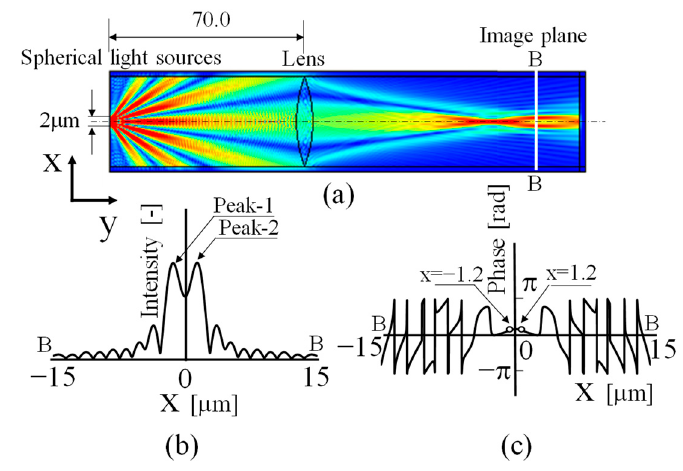
Figure 5. Simulated results when two light sources are set further than the Rayleigh criterion. ( a ) Electromagnetic field simulation result. ( b ) Intensity distribution in section B-B. ( c ) Phase distribution in section B-B.